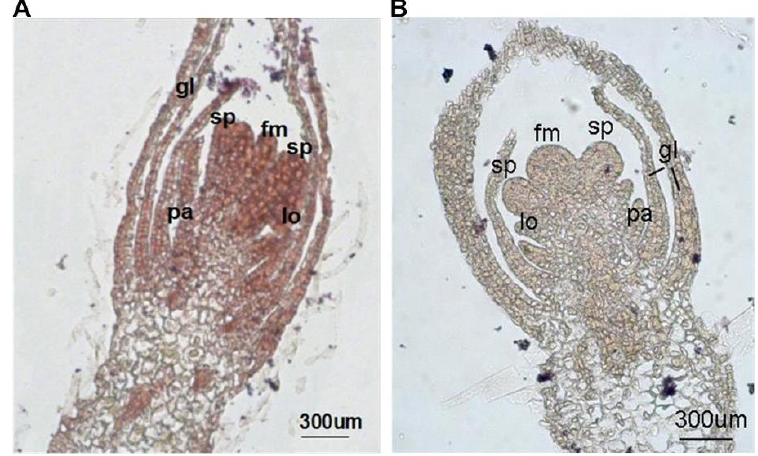
Figure 6. ScRpb4 expression in reproductive meristems. ( A ) Hybridization signal of ScRpb4 mRNA across longitudinal sections of meristems during reproductive development. ScRpb4 expression is represented as purple precipitate. ( B ) Expression of sense probes used as a control. No hybridization signal was observed. gl, glumes; pa, palea; lo, lodicules; sp, spikelet pair meristem; fm, floral meristem. Scale bar = 300 µm.